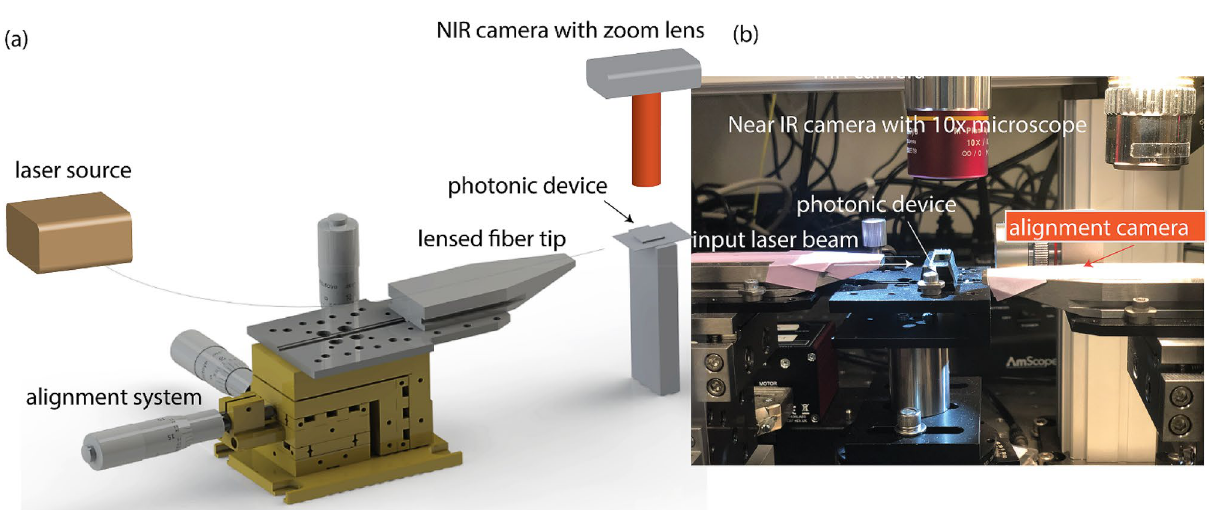
Figure 9. The experimental characterization workbench setup for the photonic device characterization. ( a ) Schematic of the setup (created in Solidworks Standard). ( b ) Experimental setup with NIR and visible microscopic cameras to monitor the device